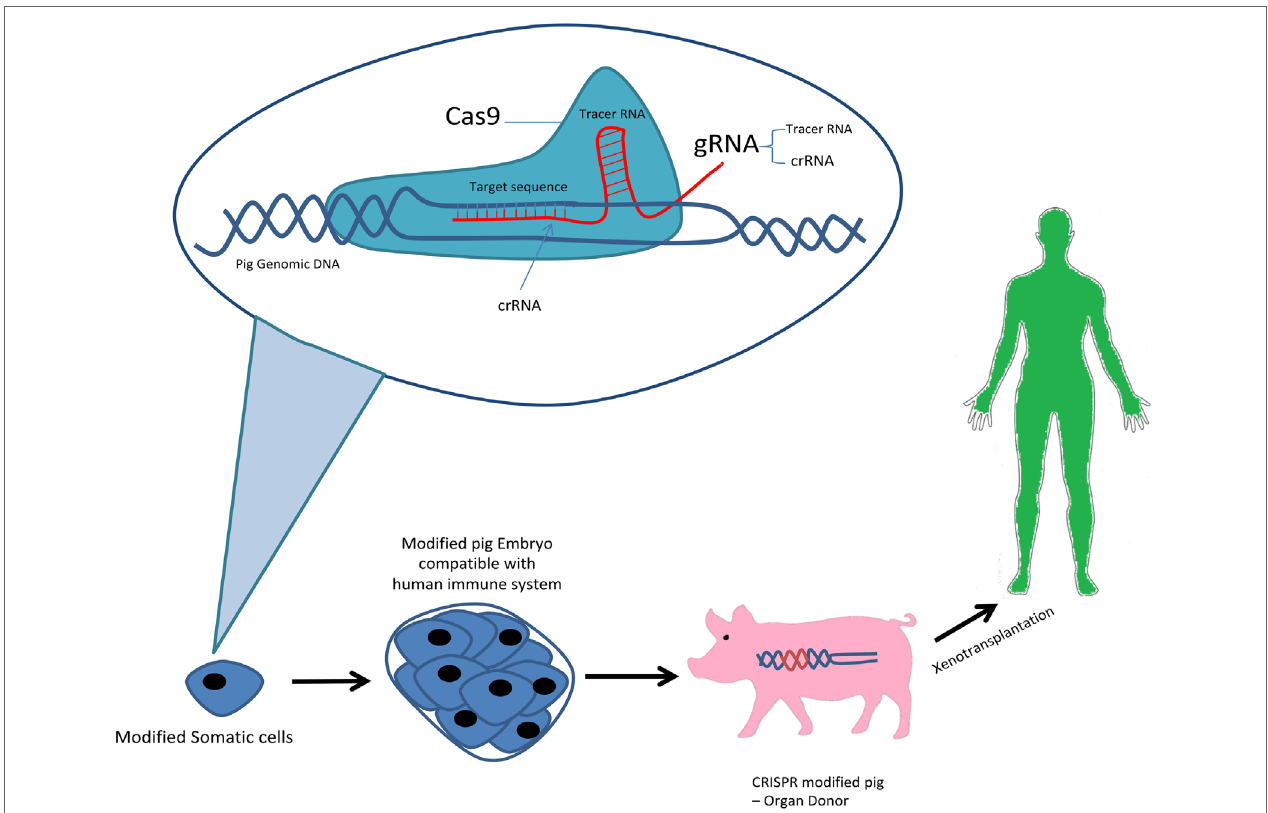
FiGURe 1 | CRISPR system in